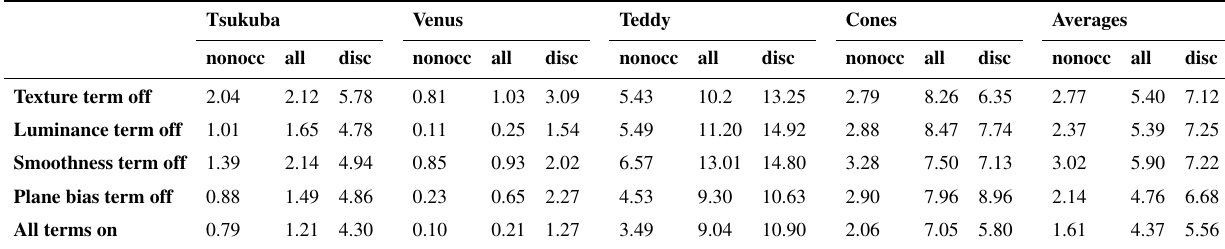
Table 4. Error statistic for the Middlebury datasets with different constraint terms turned off. “Averages” are the average percentages of error pixels over all images in different regions. Tsukuba Venus Teddy Cones Averages nonocc all disc nonocc all disc nonocc all disc nonocc all disc nonocc all disc Texture term off 2.04